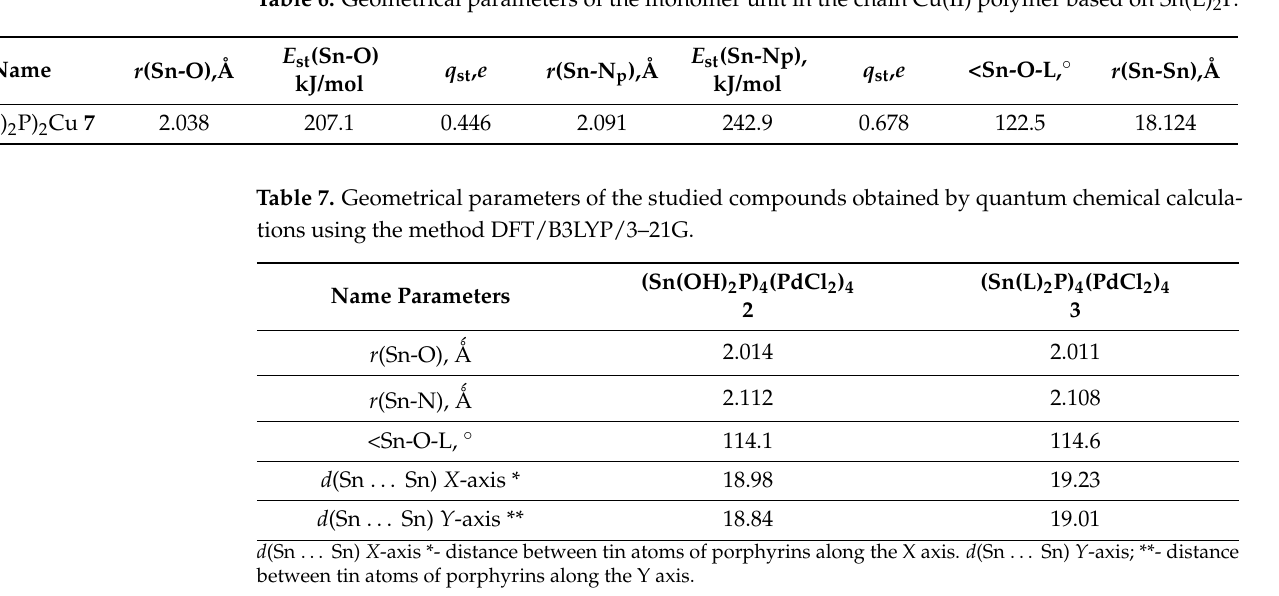
Table 6. Geometrical parameters of the monomer unit in the chain Cu(II) polymer based on Sn(L) 2 P.